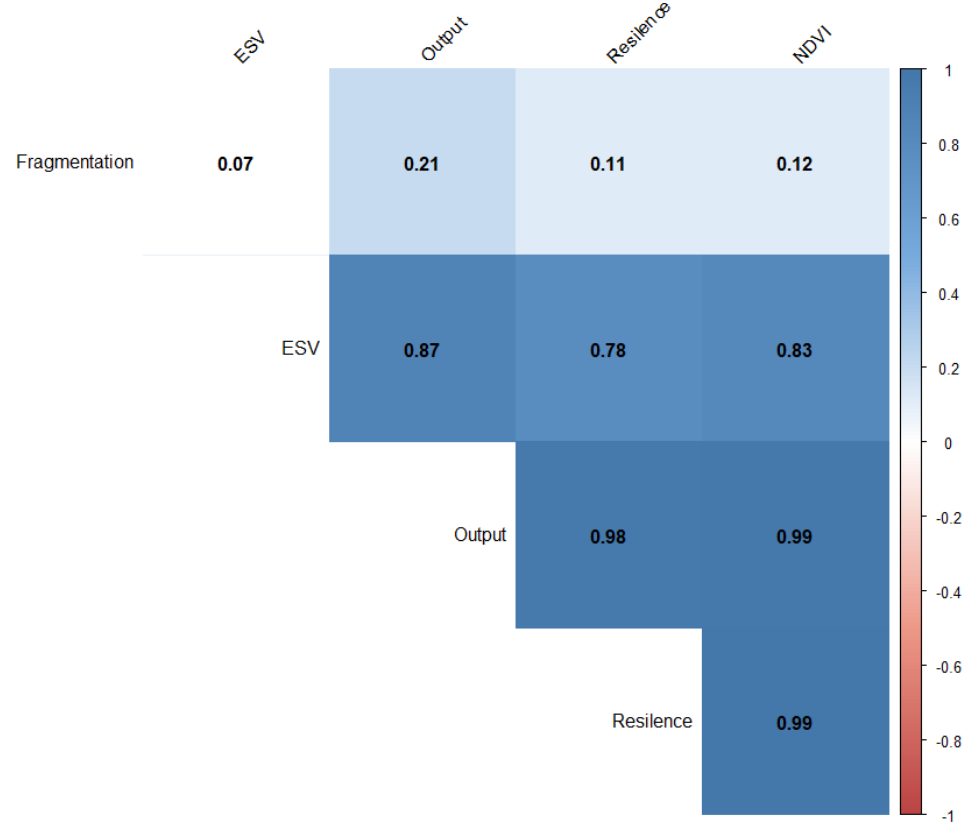
Figure 7. Relationship between EH driving parameters and ecosystem health model of 2028 using the correlation technique. the correlation